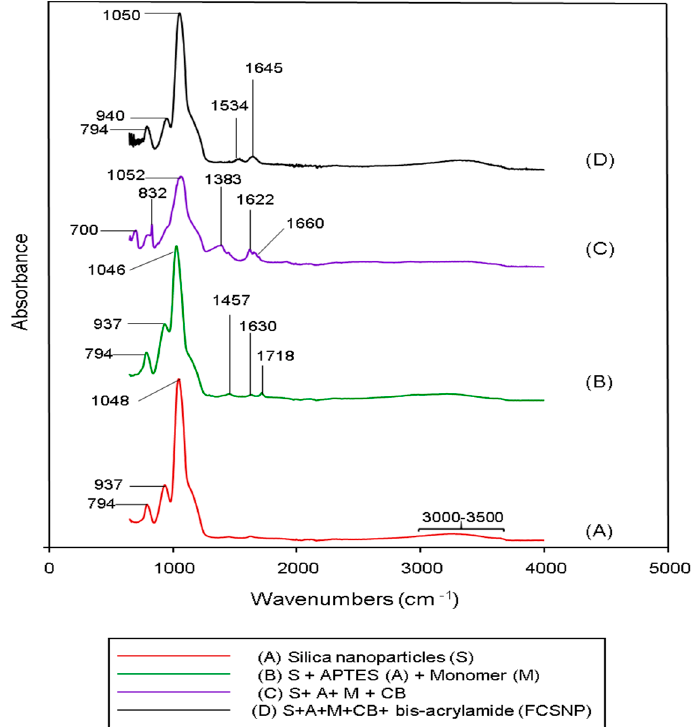
Figure 2. ATR-FTIR of the powders prepared from the nanoparticles at every stage of synthesis. ( A ) Corresponds to pure silica nanoparticles “S”; ( B ) is S + APTES “A” + monomer “M”; ( C ) is S + A + M + Cibacron blue “CB”; and ( D ) is S + A + M + CB + bis-acrylamide (FCSNP).